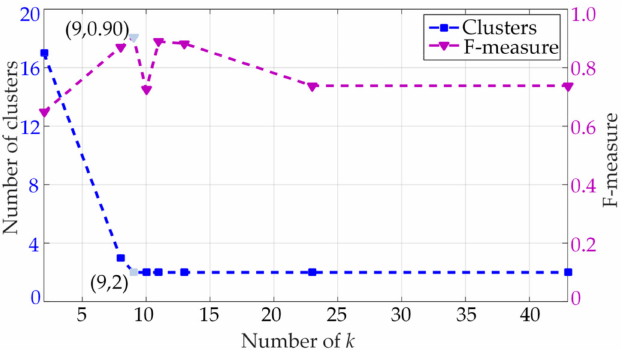
Figure 12. The relationship between the number of k , number of clusters, and the F-measure index with the measured